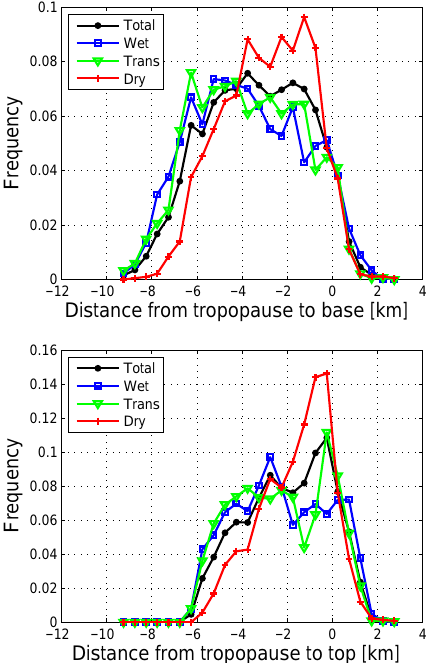
Figure 7. Normalized histograms of the distance of the tropopause to the cirrus base and top are shown for overall period (black) and each season (colors). Negative values mean that clouds are below tropopause. The average tropopause altitude was 16.2 ± 0.4km.